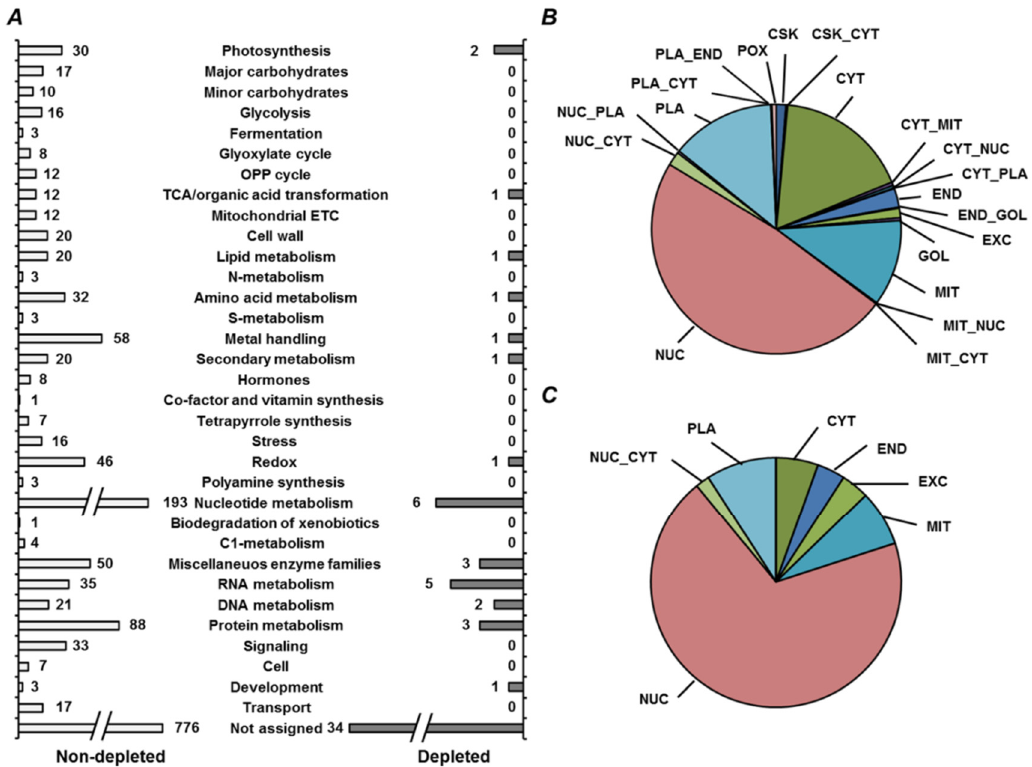
Figure 9. Functional annotation ( A ) and prediction of subcellular localization ( B , C ) of proteins, identified both in yellow seeds of cultivar Millennium and in green seeds of cultivar Gloriosa in nondepleted samples (white color in panels A and B ) and after treatment with 0.07% ( w/v ) protamine sulfate (grey color in panels A and C ). Subcellular fractions: CSK, cytoskeleton; CYT, cytoplasm; END, endoplasmic reticulum; EXC, extracellular/secreted; GOL, Golgi apparatus; MIT, mitochondria; NUC, nuclear; PLA, plasma membrane; POX, peroxisome; doubled labels denote corresponding combinations of possible localization.